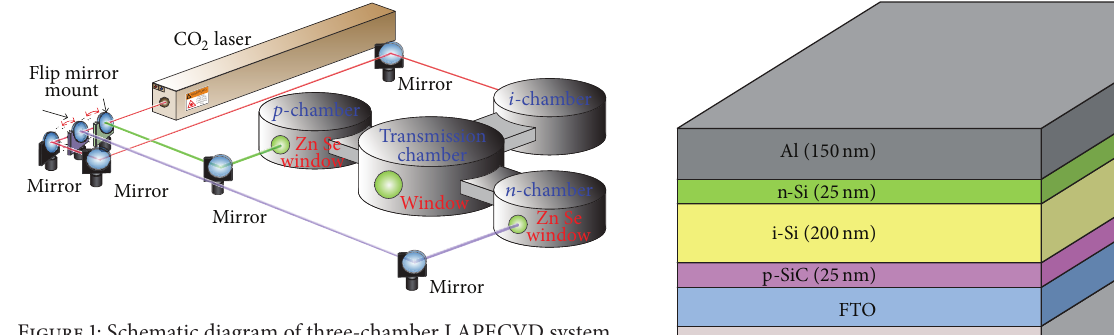
Figure 1: Schematic diagram of three-chamber LAPECVD system.